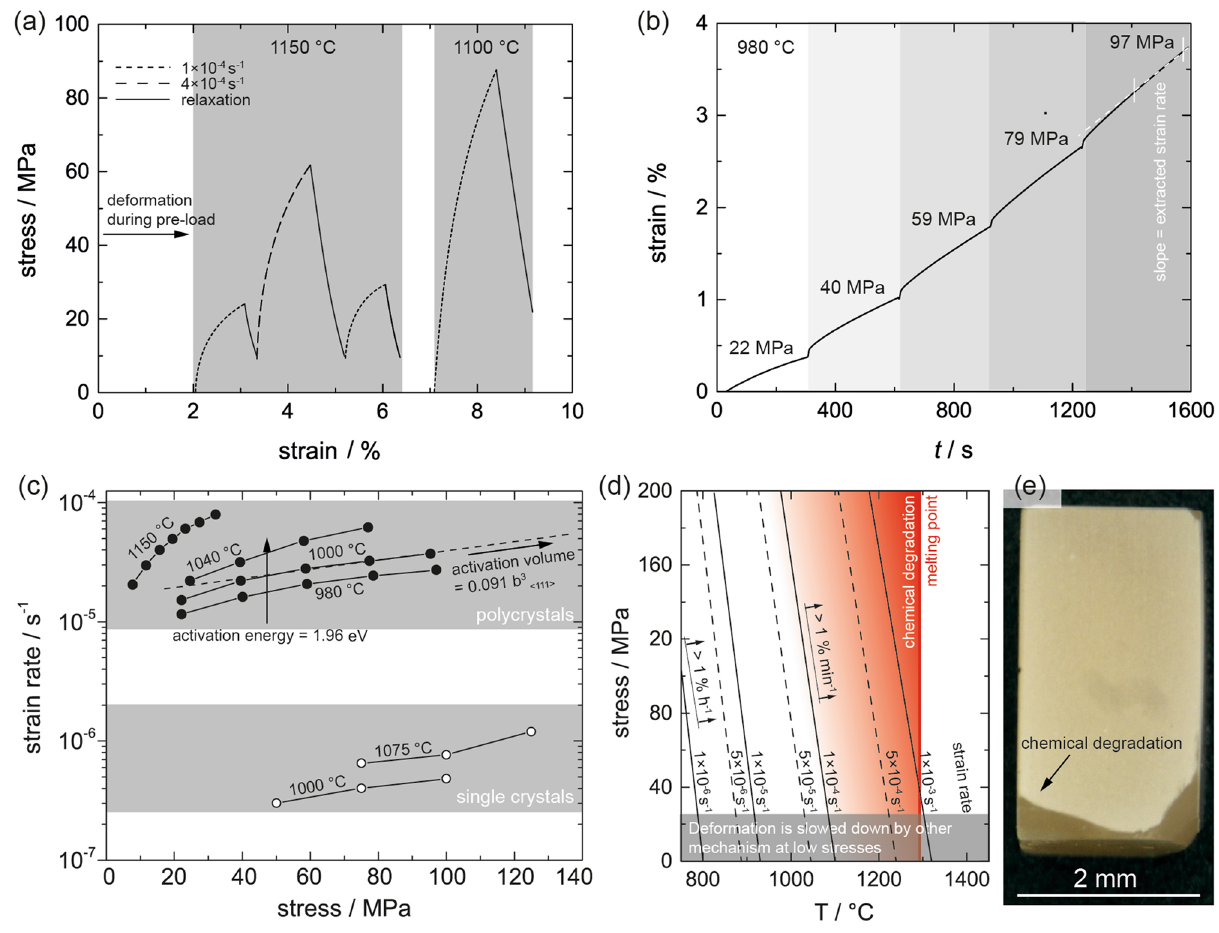
Figure 1. ( a ) Stress strain curves of LLZTO deformed at 1150 °C and 1100 °C. Multiple loading and deformations beyond 10% are possible at low stresses. Strain rate and temperature impact the deformation behavior significantly. ( b ) Strain in dependence of time measured in response to an applied stress during an experiment where stress is increased stepwise and held constant in between. The slope of the strain is extracted as the strain rate and used in ( c ). ( c ) Strain rate in dependence of stress as extracted from experiments demonstrated in Figure ( b ). In the range of 980 °C to 1040 °C polycrystalline LLZTO can be reliably deformed. At 1150 °C deformation is still possible, however, chemical degradation causes severe problems. Single crystalline LLZTO was observed to deform at much lower rates under comparable conditions. ( d ) Achievable strain rate determining the maximum possible deformation rate of polycrystalline LLZTO plotted as a function of applied stress and temperature. Chemical degradation occurs increasingly fast at temperatures just below the melting point, indicated in red shades. At too high stress, fracture can occur instead of deformation. At too low stress, however, deformation is retarded by other mechanisms. Consequently, a field of feasible processing parameters is defined and this graphic allows to identify the achievable strain rate immediately. ( e ) LLZTO polycrystal deformed by 5% at 1040 °C with a thin chemically degraded layer on the